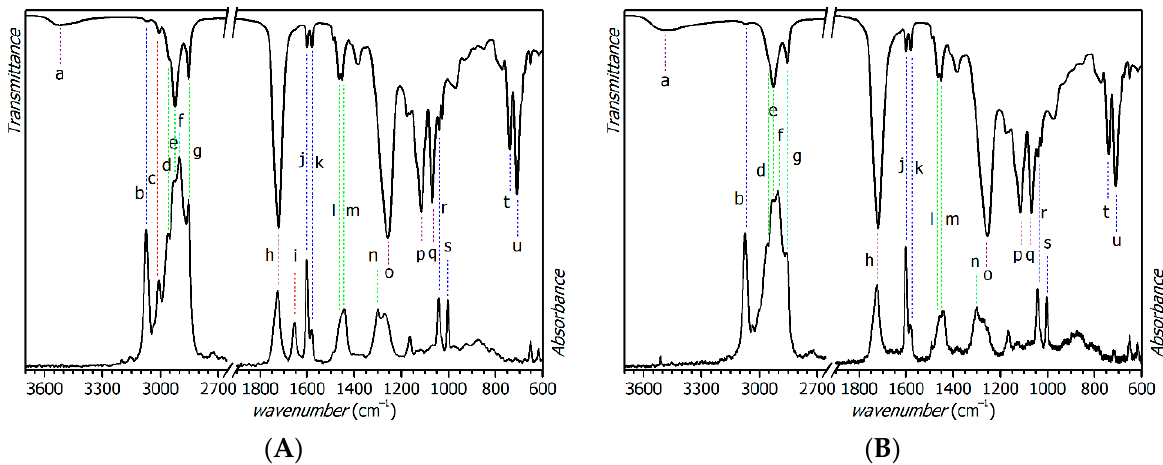
Figure 2. Infrared (top) and Raman spectra (bottom) of S471 formulations: ( A ) after solvent evaporation (no drier used); ( B ) after room temperature curing for 100 days (treated with Fe-diiPc, 0.001 wt.%). Colors: red—bands disappearing upon curing; green—aliphatic chains; blue—aromatic rings; purple—OH and ester functions. Table 4. Assigned characteristic vibration modes for binder S471 1 .